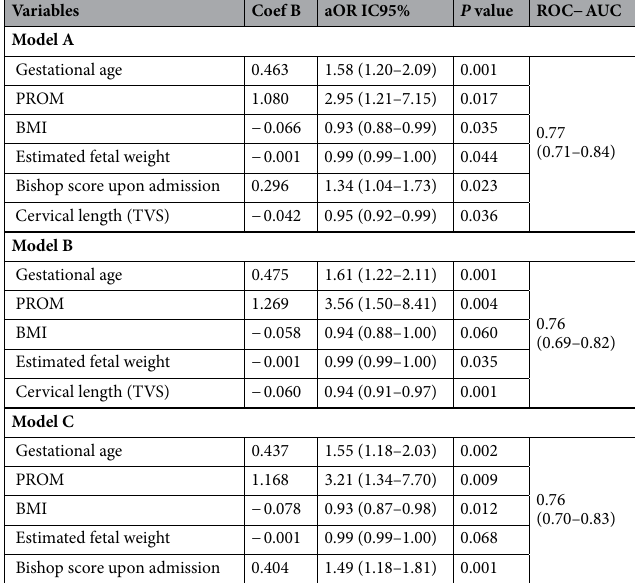
Table 3. Predictive models for cervical ripening. Multivariable analysis.